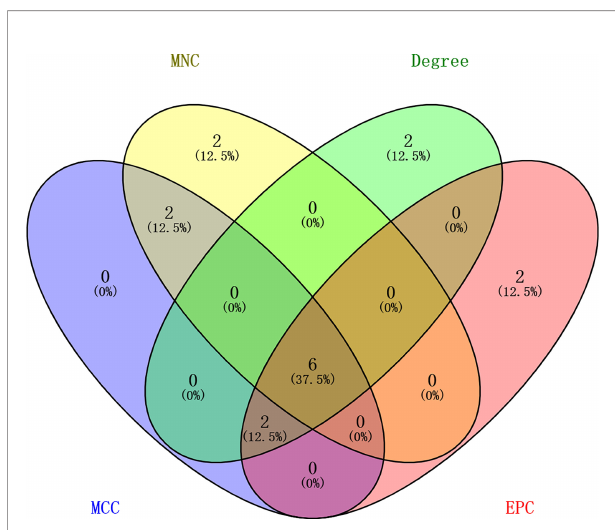
FIGURE 6 | Identi fi cation of the six core immune-related mRNAs in the PPI network via four algorithms in